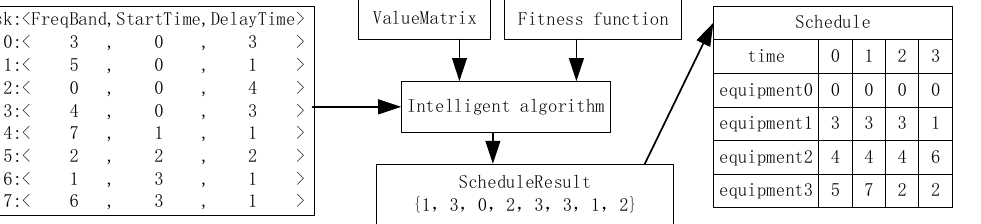
Figure 2. Example of DSTT.